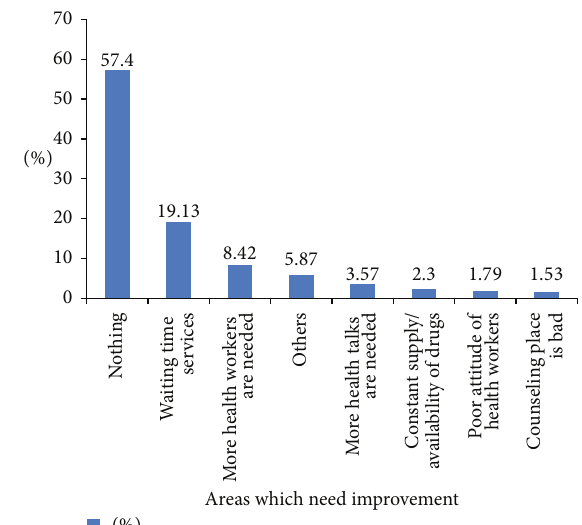
Figure 3: Challenges which need to be improved upon as reported by patients in Kamuli district health facilities, March–May